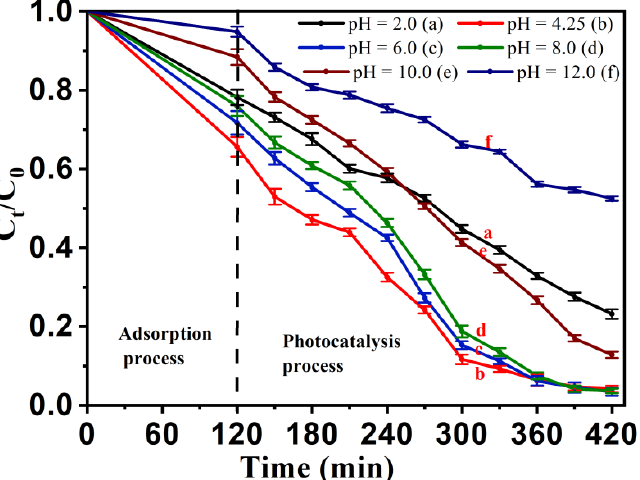
Figure 11. The decomposition of PR (100 ppm) by CuH–3.5 sample at different medium pH values.